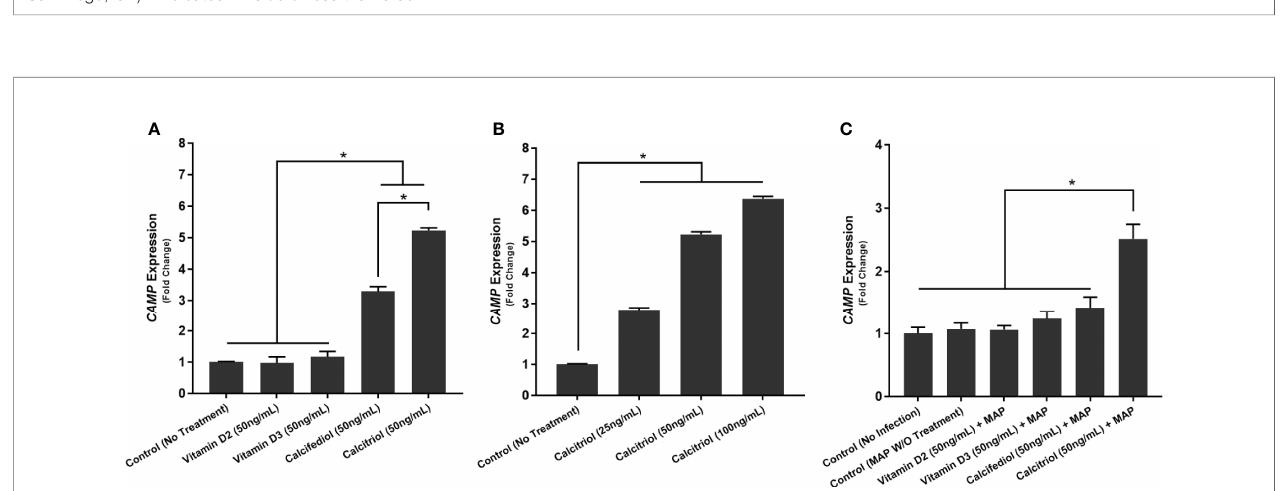
FIGURE 2 | Effect of different forms of vitamin D (A) and different concentrations of calcitriol (B) on CAMP expression in the presence of MAP infection (C) . Relative expression was quanti fi ed using RT-qPCR. *Indicates P-value of less than